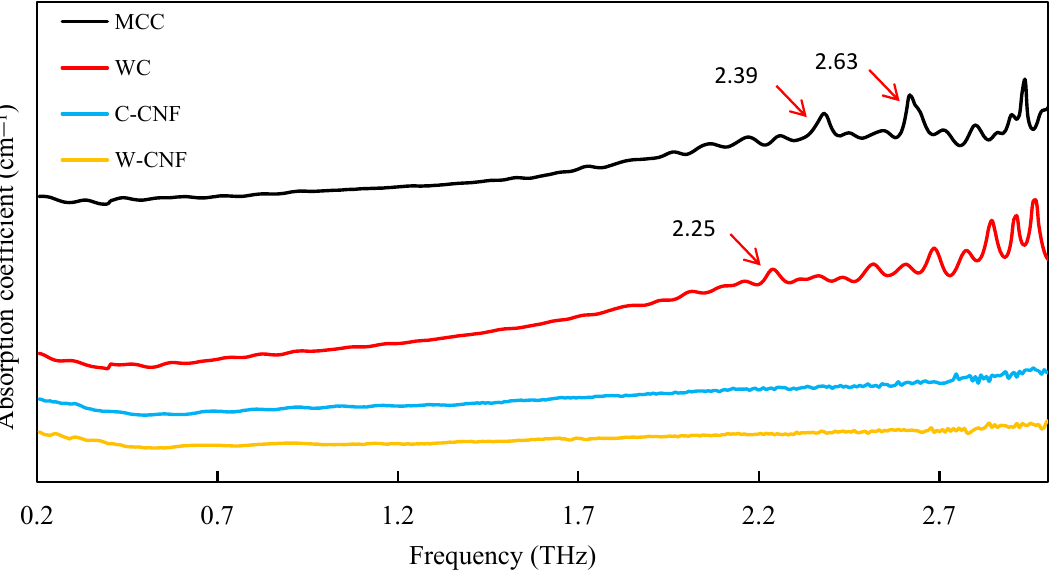
Figure 7. THz test of different cellulose samples.